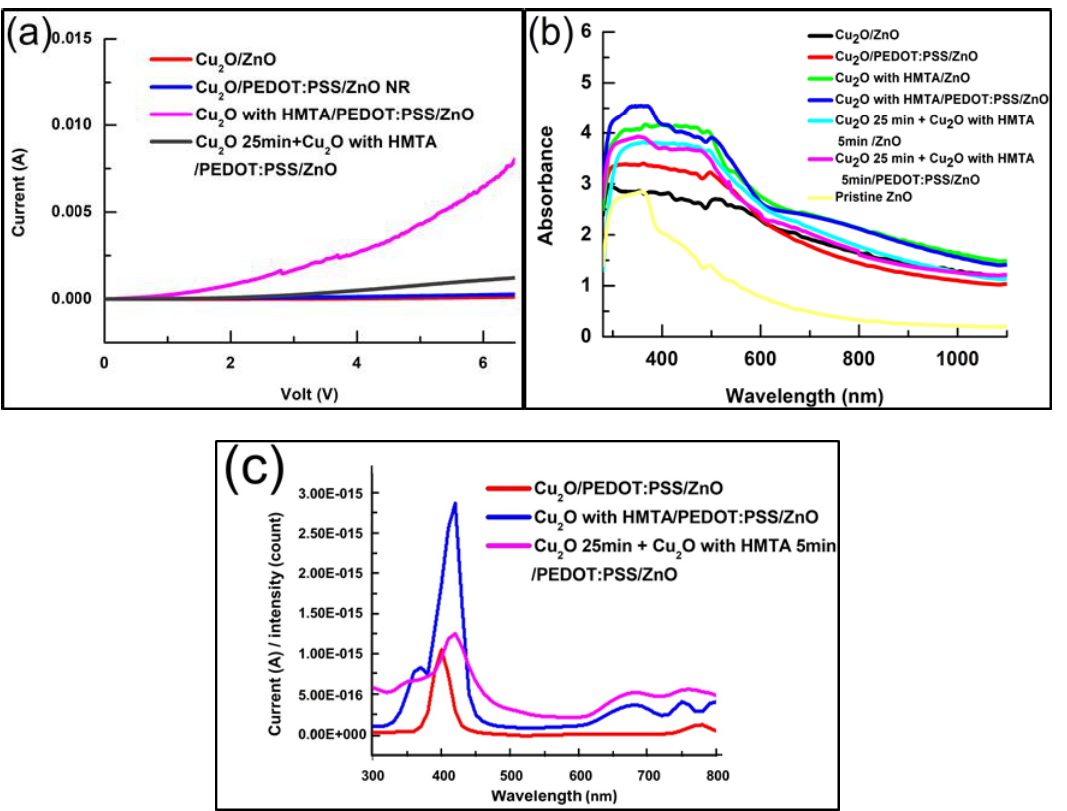
Figure 5. Electrical and optical properties of the biosensors in the depositional environment with different electrolytes: ( a ) I–V characteristics under bias potentials from 0 to 6 V; ( b ) absorption spectra in the range 300–1000 nm; ( c ) photo-response spectra from 300–800 nm.